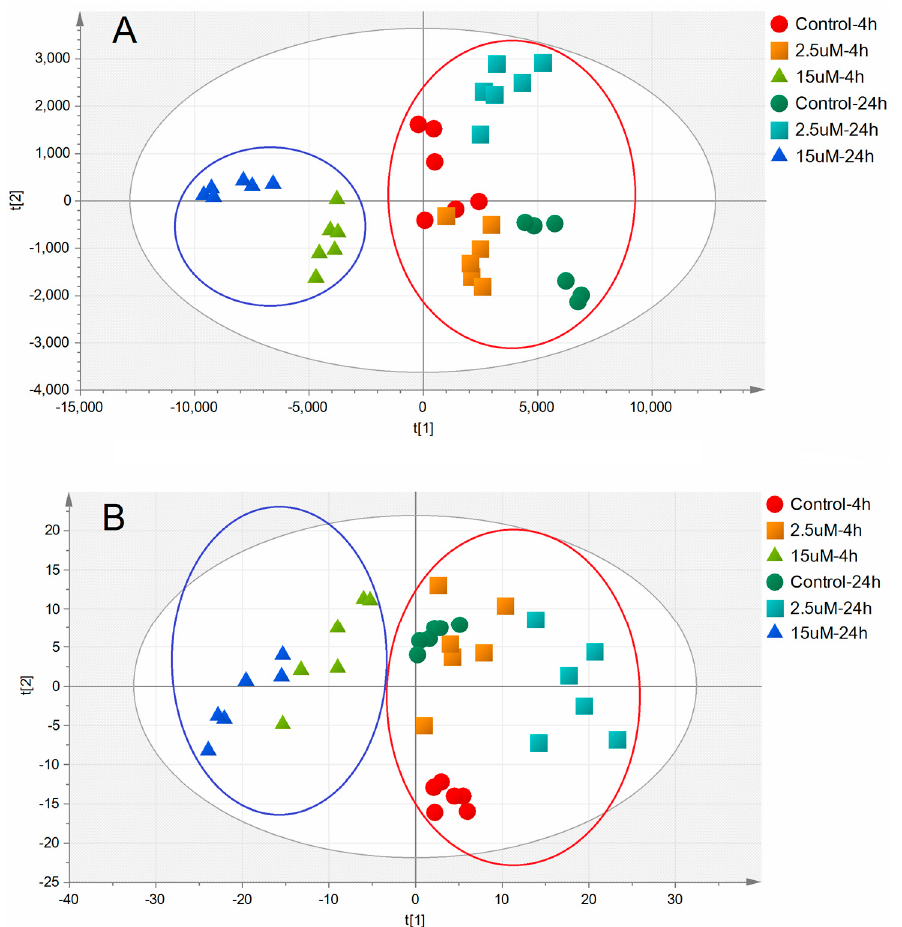
Figure 4. Multivariate analytical results of extracted metabolites in HL-60 cells with or without Ara-C treatment. ( A ) 2D PLS-DA score plot of NPs data; ( B ) 2D PLS-DA score plot of dNP data. Scores t[1]